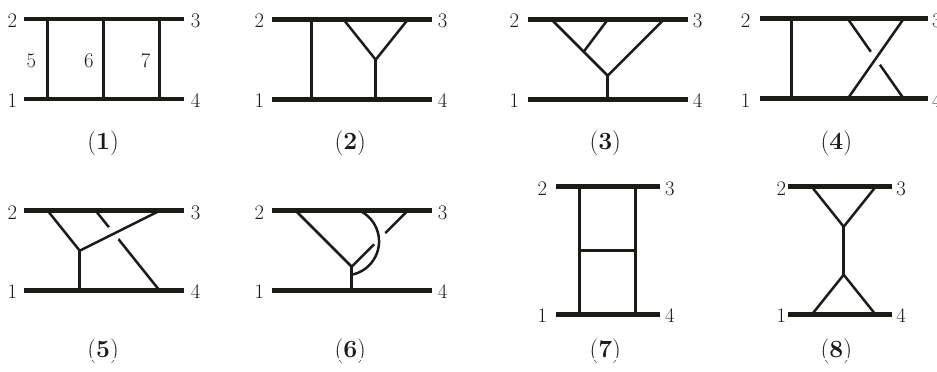
Figure 14 . The eight independent diagrams with only cubic vertices showing the propagator structure of integrals which contribute to the classical potential. The thick lines correspond to massive particles. All other diagrams are given by relabeling the external legs. In the main text, we will denote each diagram using bold label, e.g. diagram 1 for the (cid:12)rst